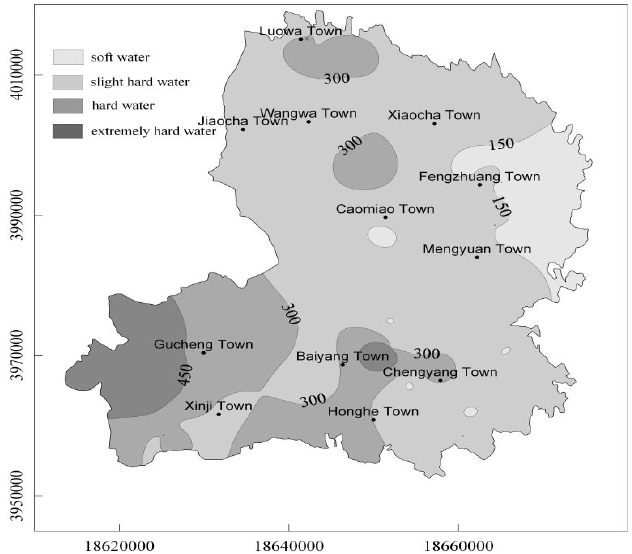
Figure 3. Zoning map of TH in Pengyang drinking